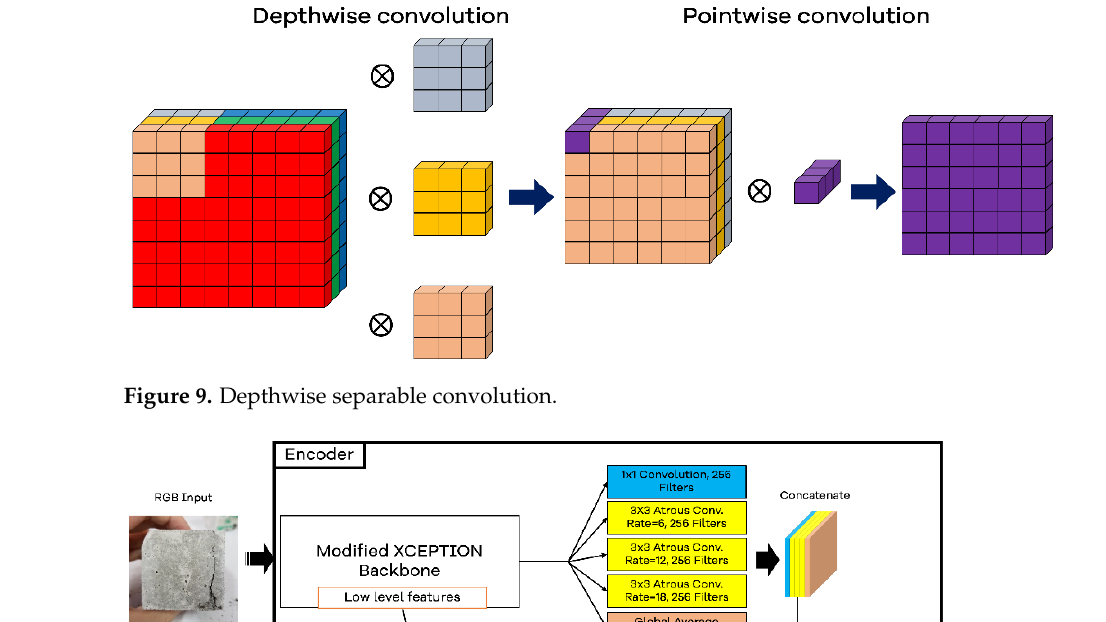
Figure 8. Modified Xception backbone.